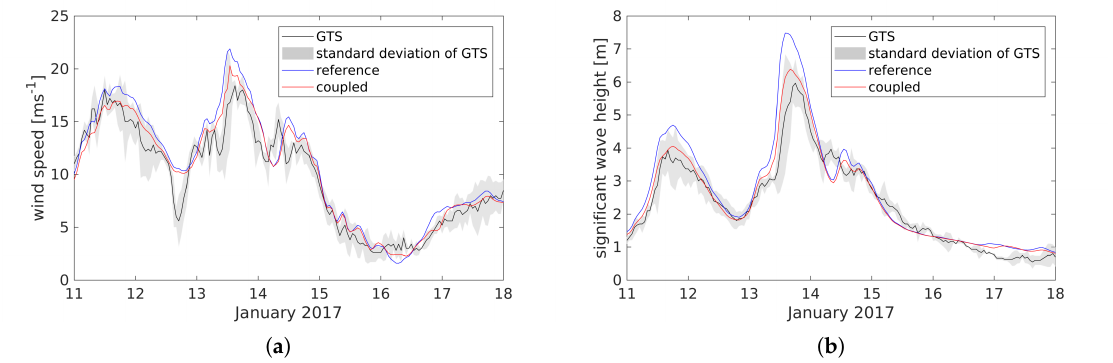
Figure 6. Time series of GTS measurements versus the simulated results of the ( a ) wind speed (m s − 1 ) and ( b ) significant wave height (m) off the coast of England (53 ◦ N,0 ◦ E to 54 ◦ N,3 ◦